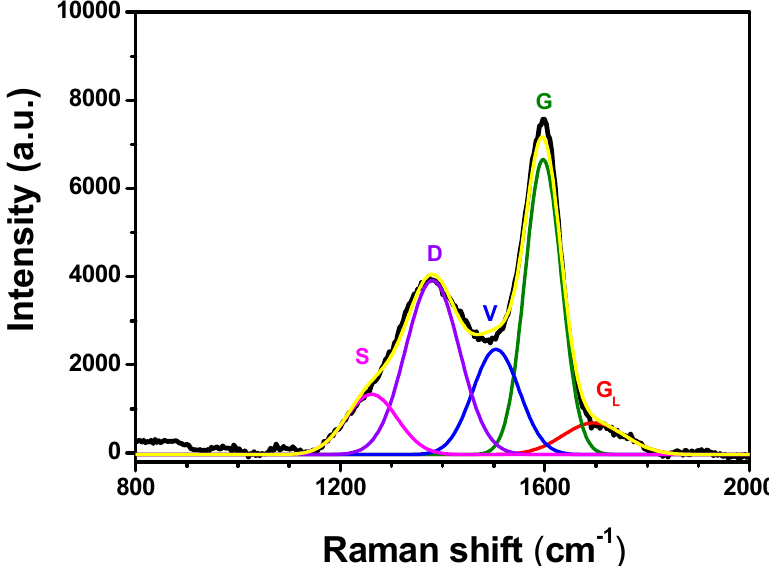
Figure 6. Peak-fitted Raman spectrum of olive pit biochar.